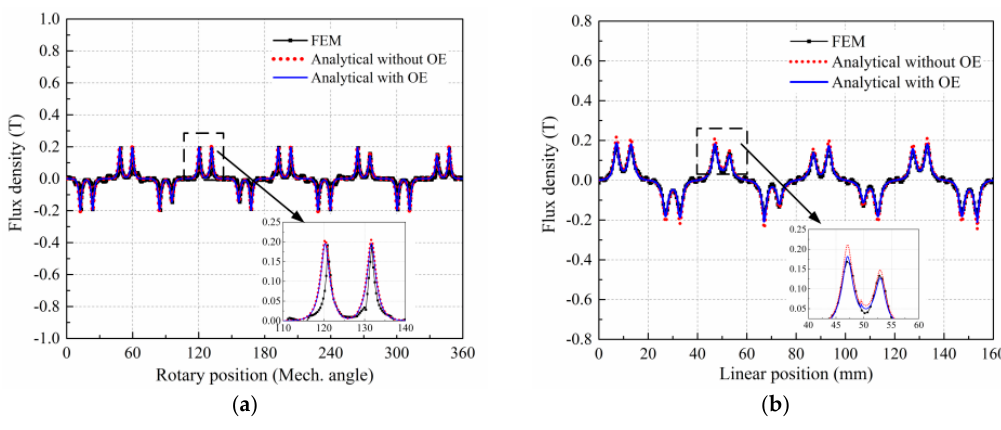
Figure 12. Tangential flux density of the DSLRPMM. ( a ) Rotary motion unit; and ( b ) linear motion unit.